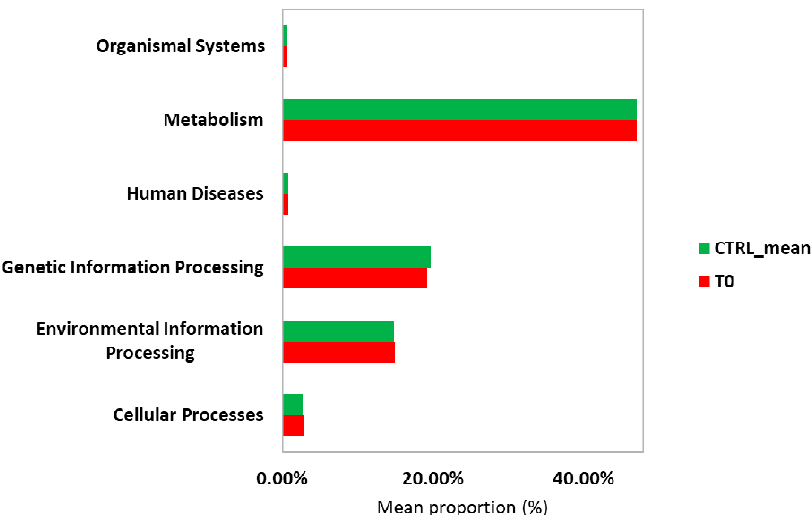
Figure 7. Predicted functional pathways (KEGG Level I) of the gut microbiota during infection (T 0 ) with S. stercolaris .